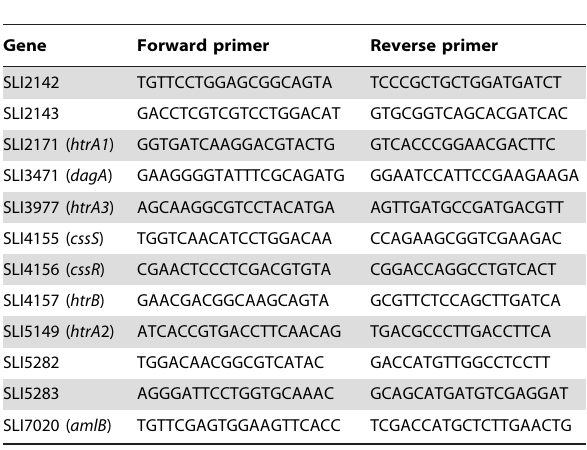
Table 1. Oligonucleotide primers used for gene transcript